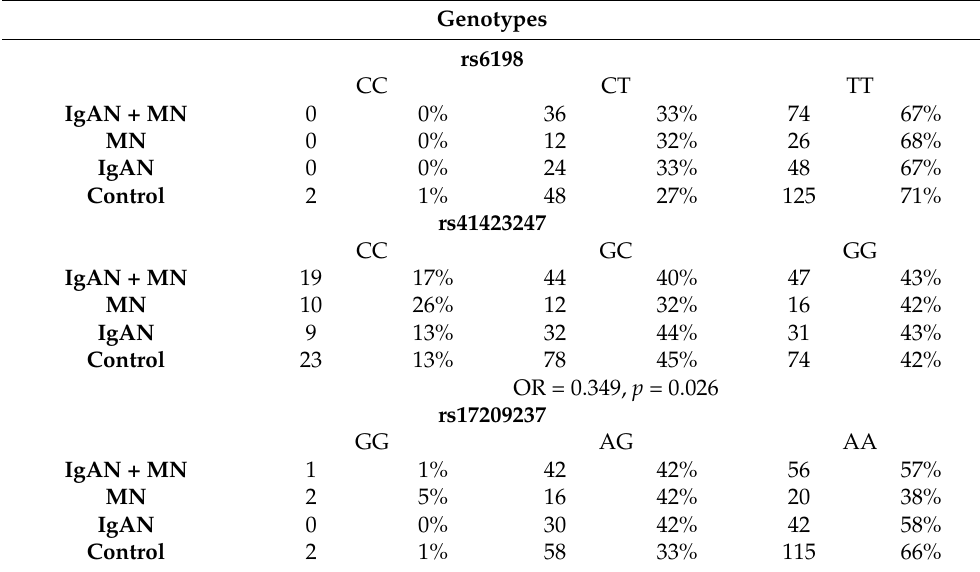
Table 4. Frequencies of rs6198, rs41423247 and rs17209237 polymorphisms in IgAN, MN and control